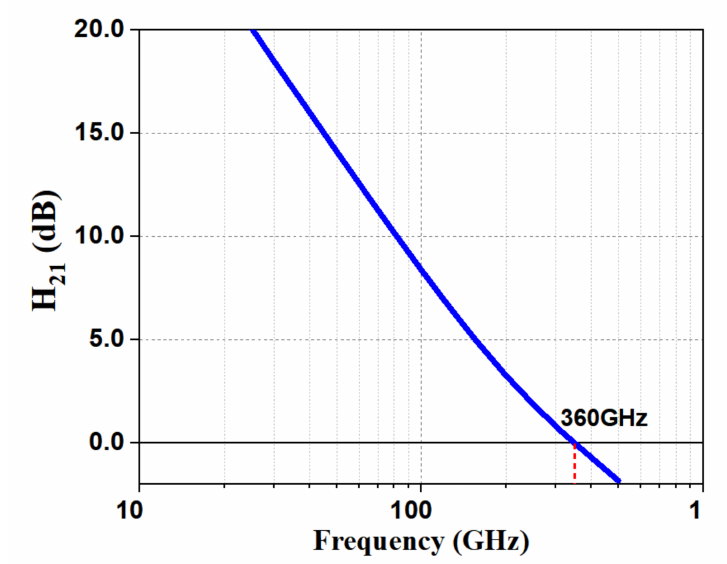
Figure 1. f T of an NPN